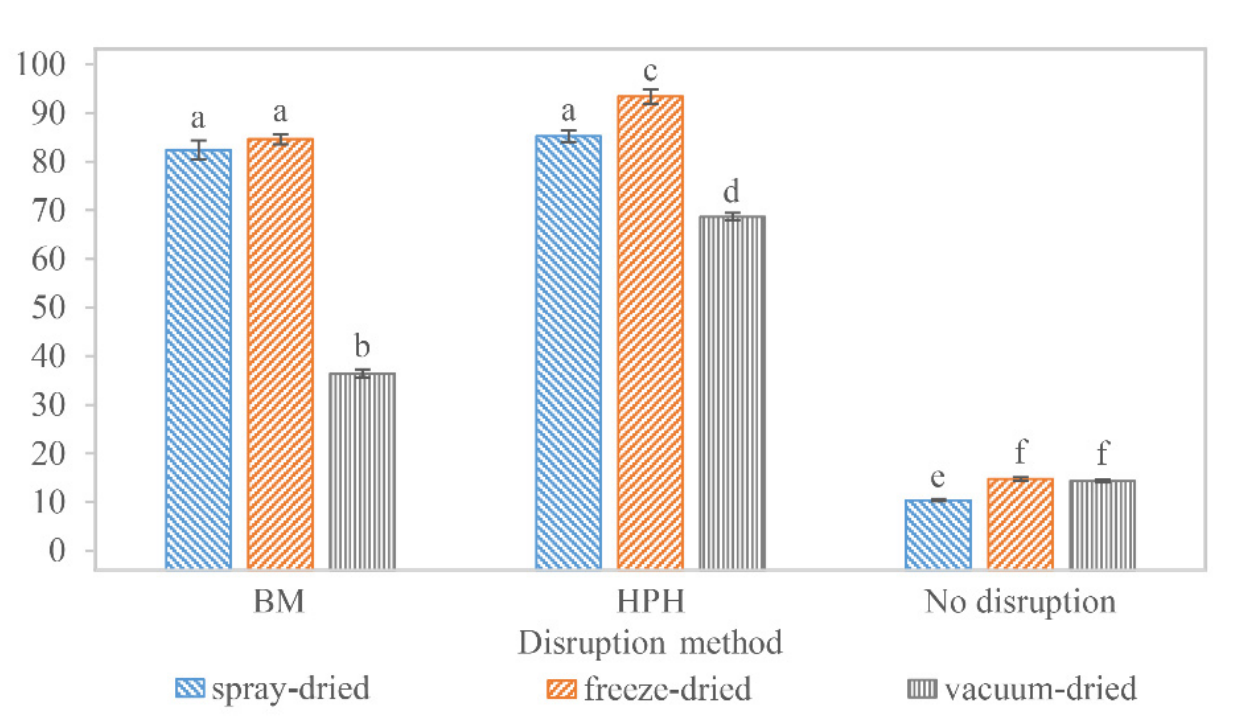
Figure 3. Astaxanthin recovery in supercritical fluid extracts of differently disrupted and dried H. pluvialis biomass. Significant differences ( p < 0.05) of the samples are indicated by different letters.